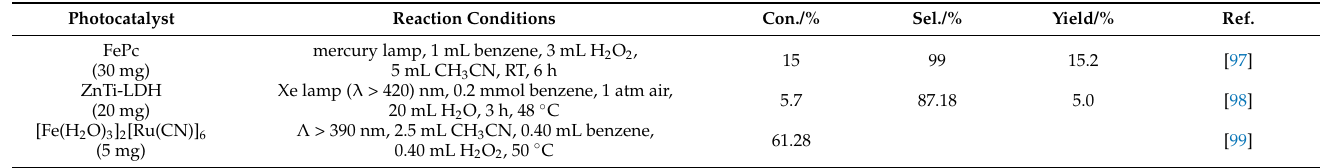
Table 6. Catalytic performance of other photocatalysts for benzene